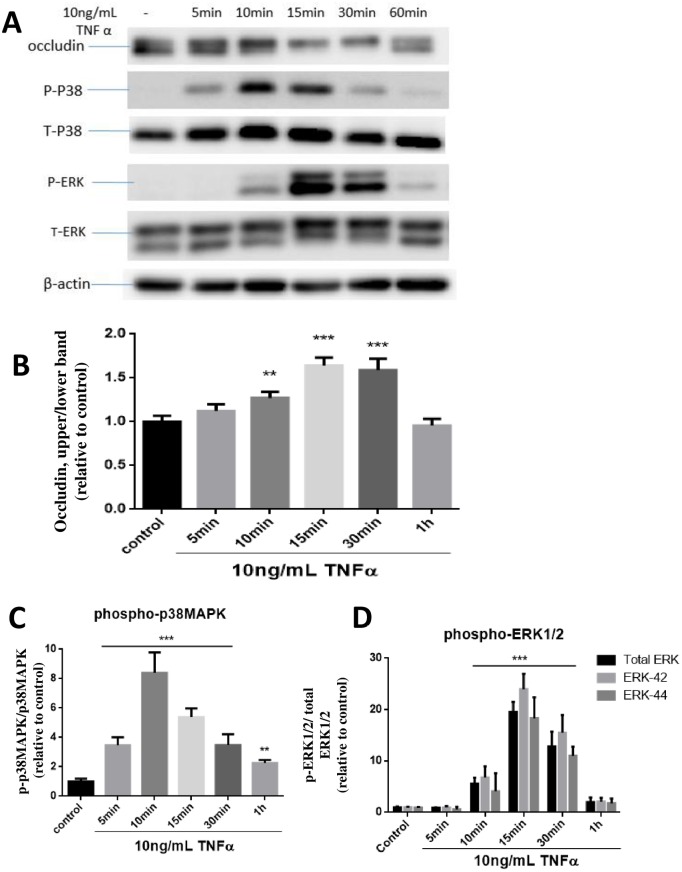
TNFα-mediated occludin band-shift and phosphorylation of ERK1/2 and p38MAPK in hCMEC/D3 cells.Cells were treated with or without TNFα (10 ng/mL) at 5, 10, 15, 30, 60 min (A). Cell lysates were collected and occludin, P- ERK, T-ERK, P-P38, T-P38 and β-actin expression pattern was analyzed by immunoblotting assay. Quantification of the proportion of occludin upper band were determined through PIupper/PItotal/PIβ-actin and then normalized to control (B). phospho-ERK1/2 (C) and phospho-p38MAPK (D) were similarly quantified and plotted. Results are mean ± SD from 3 or more experiments and data are analyzed by one-way ANOVA followed by Bonferroni post-tests (**P<0.01, ***P<0.001 compared with no treatment control).